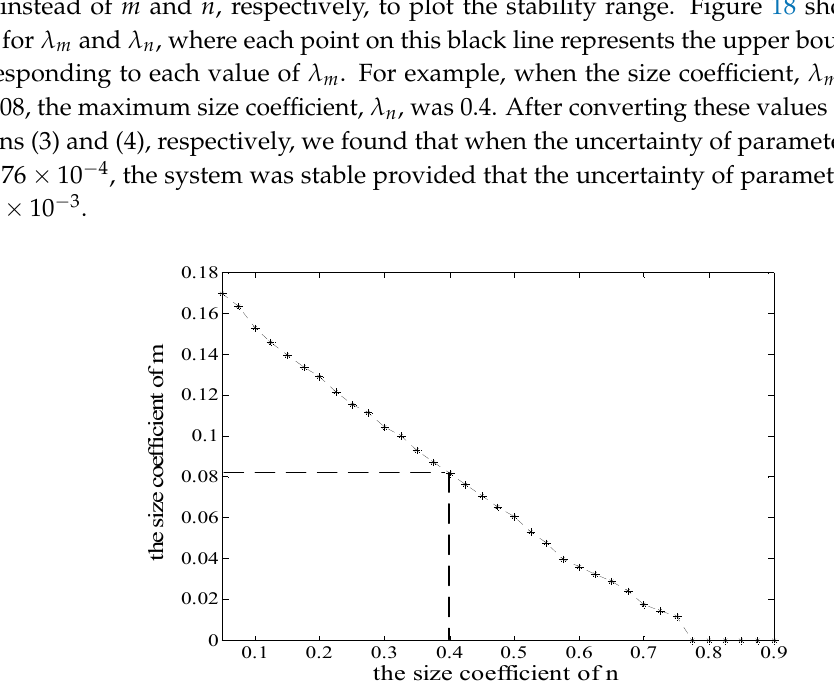
m and λ n λ and λ . m n